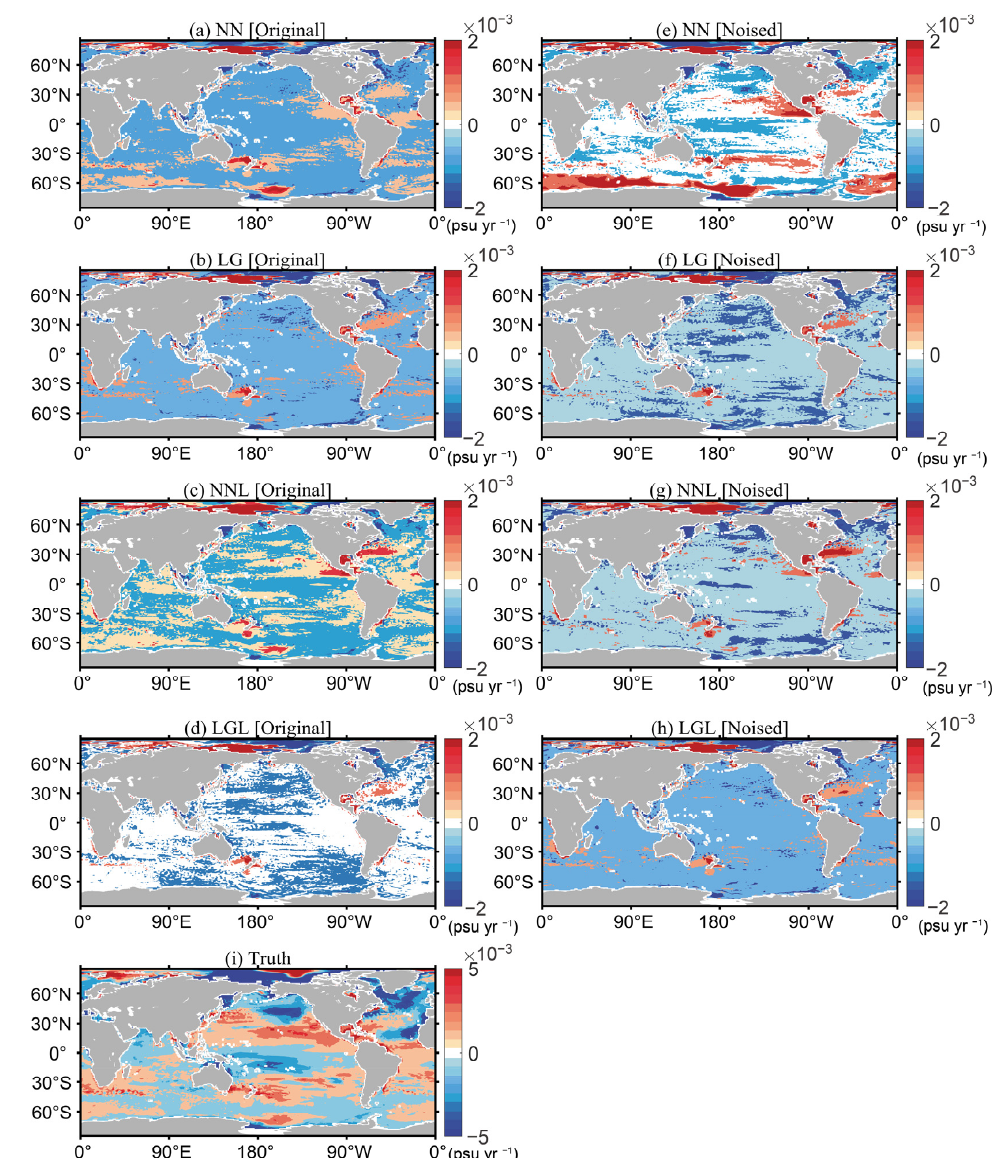
Figure 17. ( a – h ) Difference between the linear trends of the reconstructed experiment and truth values in the mean salinity of S2000 from 1993 to 2018 over the globe. ( i ) Linear trend of salinity truth value of CNRM-CM6-1-HR model.